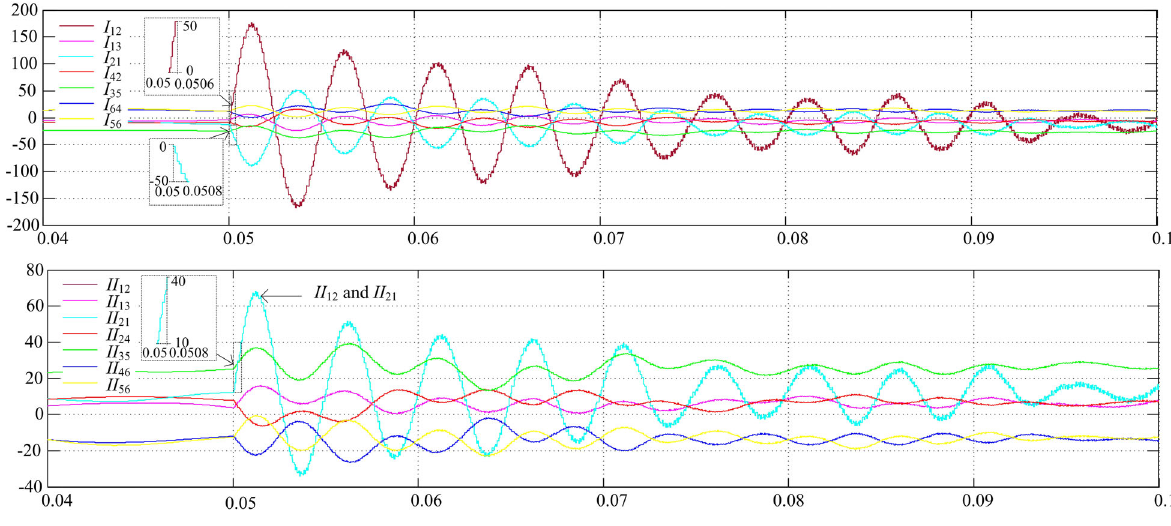
Fig. 13 Pole-to-ground fault